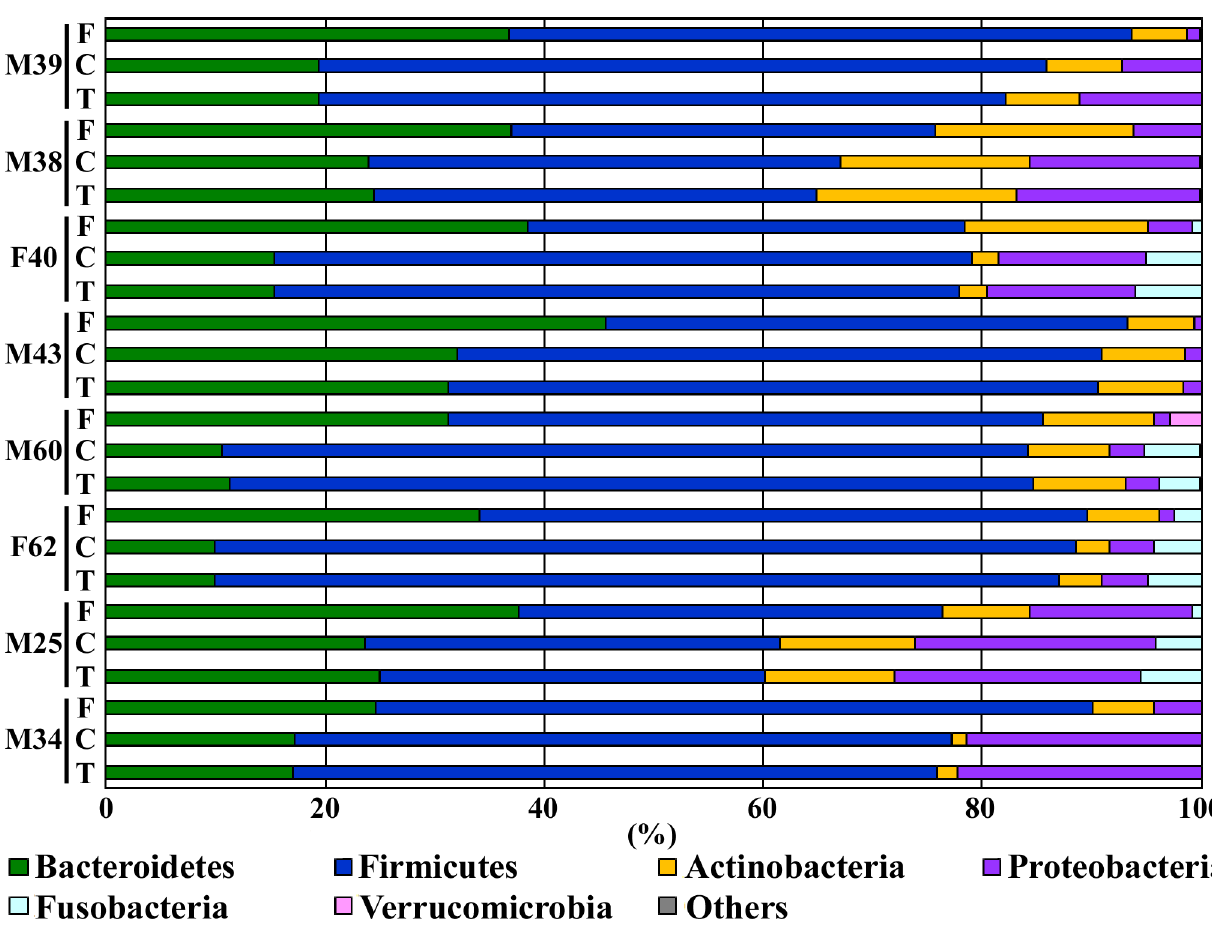
Fig 4. Phylum-level compositional view of bacteria in the eight human fecal samples used as inocula (“F”), in corresponding KUHIMM cultures at 30 h after the initiation of fermentation (“C”), and in corresponding KUHIMM cultures containing taurine at 30 h after the initiation of fermentation (“T”). Individual fecal sample sources are designatedas follows: M39 (male, age 39), M38 (male, age 38), F40 (female, age 40), M43 (male, age 43), M60 (male, age 60), F62 (female, age 62), M25 (male, age 25), and M34 (male, age 34). A compositional view of bacterial phyla basedon the taxonomic assignment of 16S rRNA genes is shown. Bacterial compositionof each sample was estimated basedon the results of the RDP classifier.